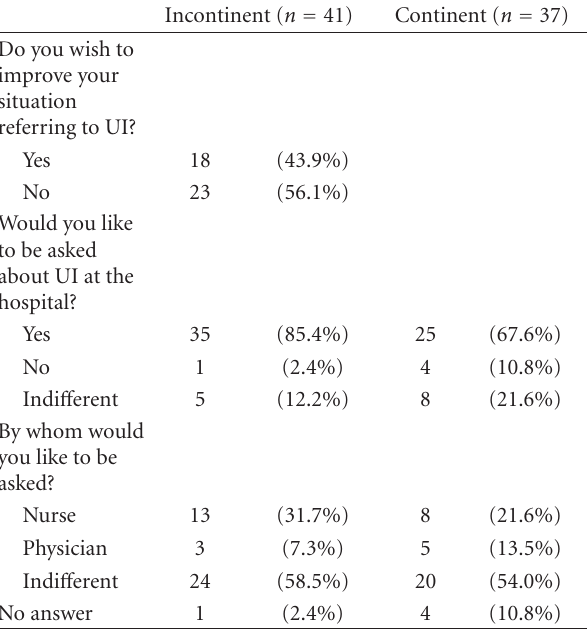
Table 3: Patients’